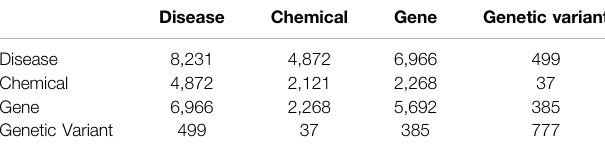
TABLE 4 | Counts of the different types of edges. Disease